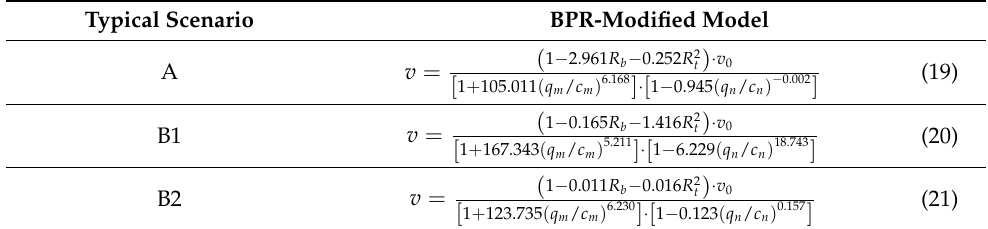
Table 7. Summary of the BPR-modified model for each scenario.